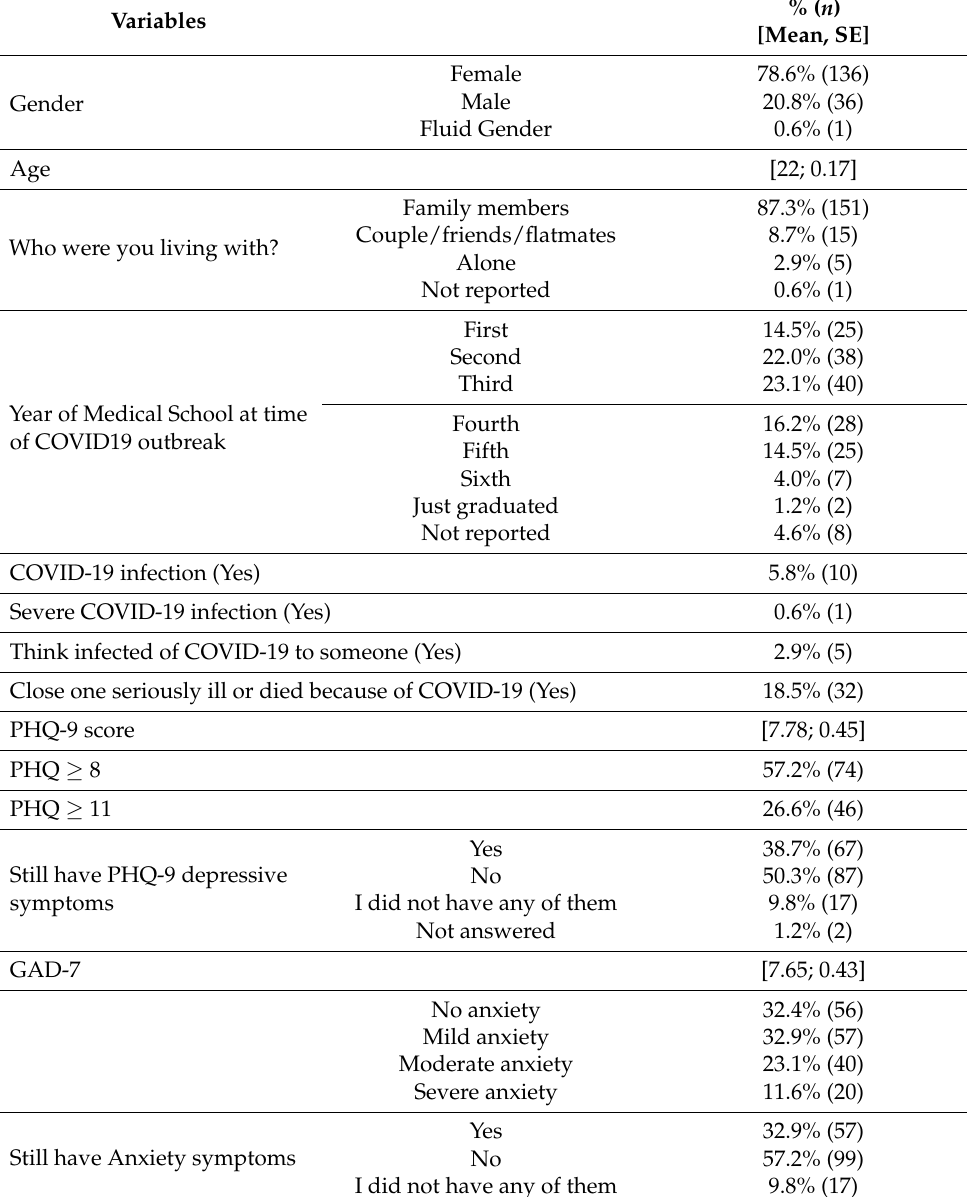
Table 1. Sociodemographic variables of the